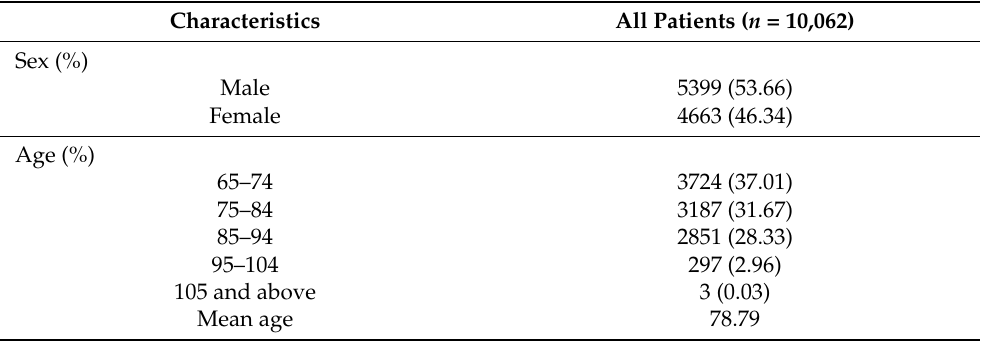
Table 2. Basic characteristics of elderly patients.